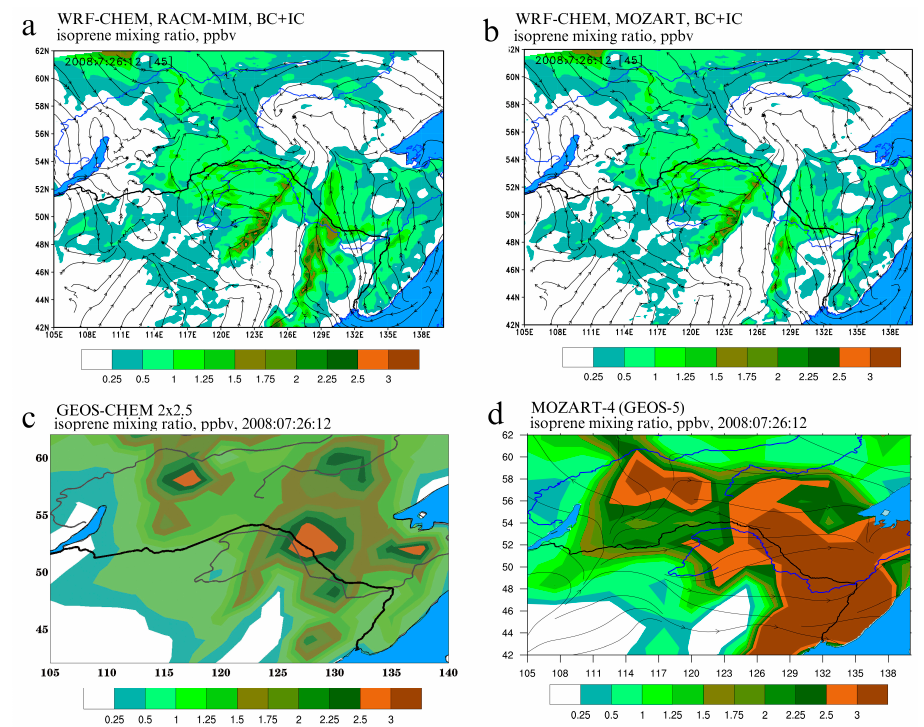
Figure 4. The result of model simulations of the isoprene spatial distribution using two